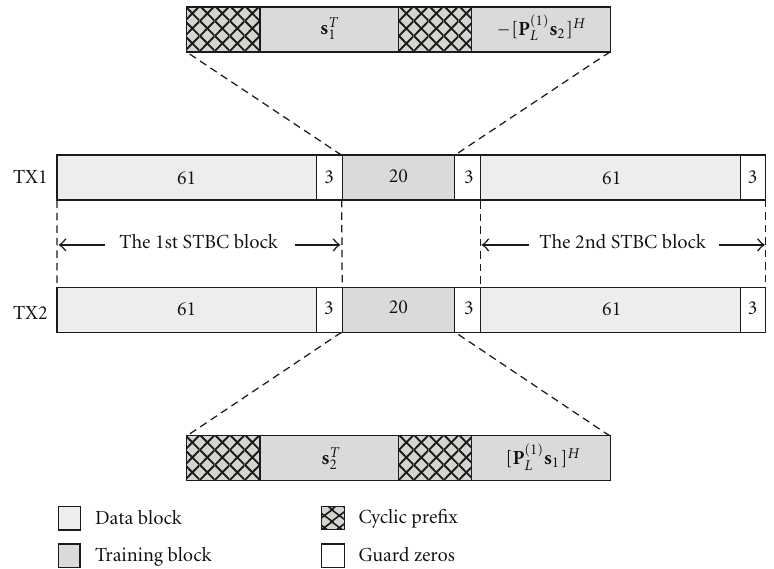
Figure 3: Block structure for both data and training